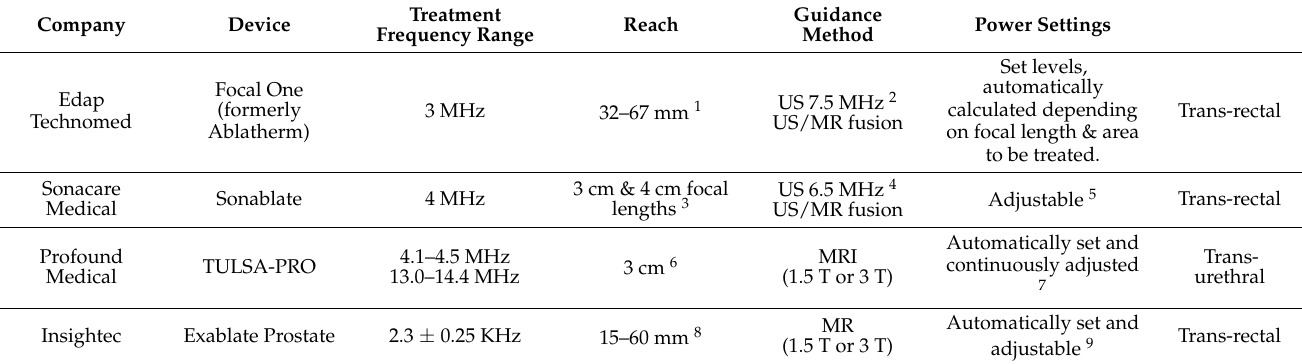
Table 1. Intracavitary devices being used for the treatment of prostate